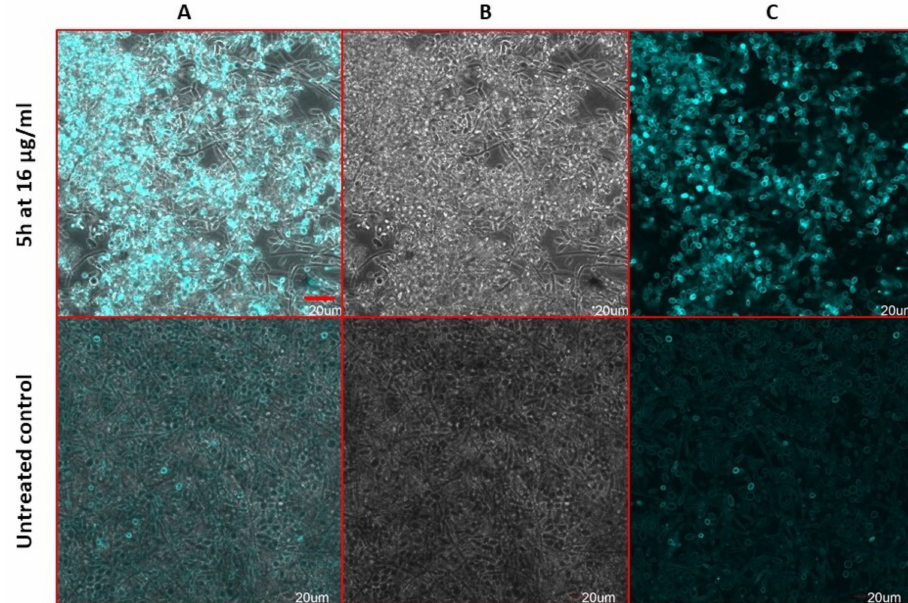
Figure 5. The fluorescent staining of the C. albicans SPZ176 biofilm with calcofluor white (CFW). Legend: Confocal laser scanning microscope (CLSM) analyses: ( A ) phase contrast and fluorescence merged; ( B ) phase contrast and ( C ) fluorescence images. ( A – C ) Upper raw depicts sessile cells treated with 5h at 16 µ g/mL; lower raw included the untreated controls. Sessile cells stained with calcofluor white (CFW) at final concentration of 2.5 µ g/mL showed vivid blue fluorescence of elevated chitin in the 5h -treated morphotypes (upper raw). Reduced fluorescence of chitin in the intact untreated control sessile cells was noted (lower